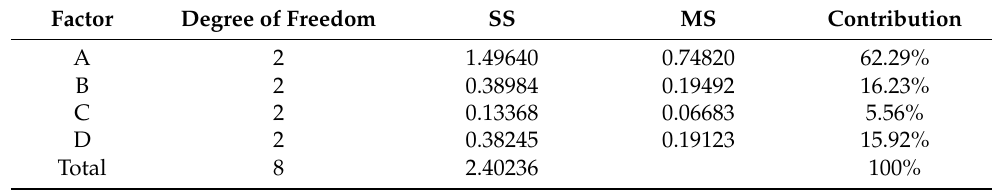
Table 6. Analysis of variation and contribution of α -Fe content of UNS31803 Duplex stainless steel.